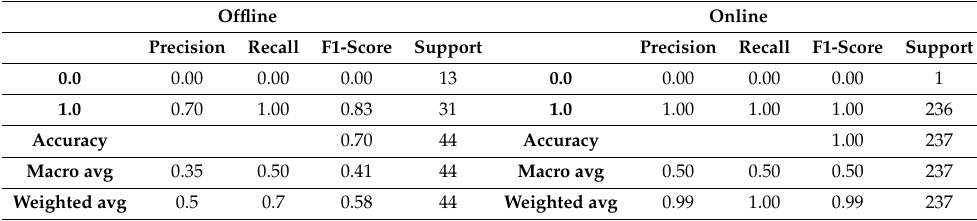
Table 4. KNN Classification